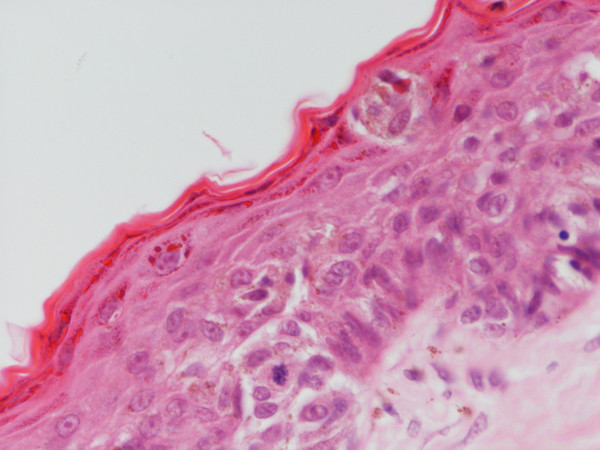
Scattered atypical melanocytes showing mitotic activity in the epidermis (HE,400×).